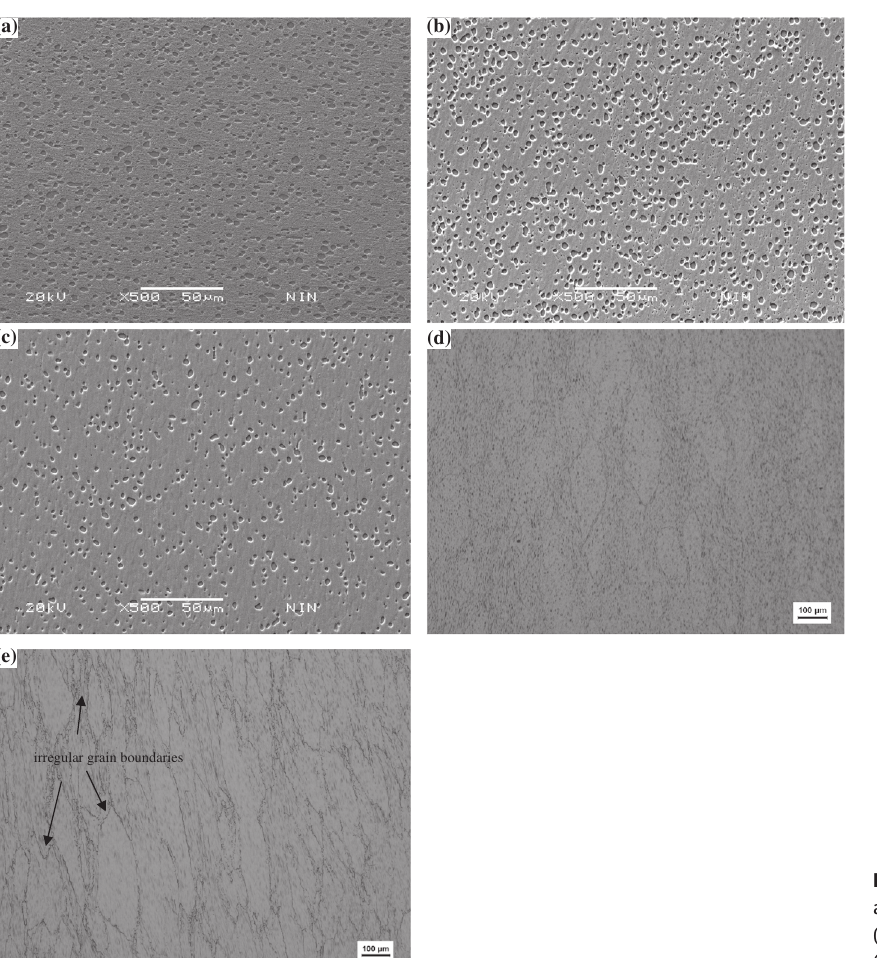
Figure 14: Microstructure of Ti555211 alloy at the strain rate of 1 s − 1 : (a) 750°C; (b) 800°C; (c) 850°C; (d) 900°C; (e)